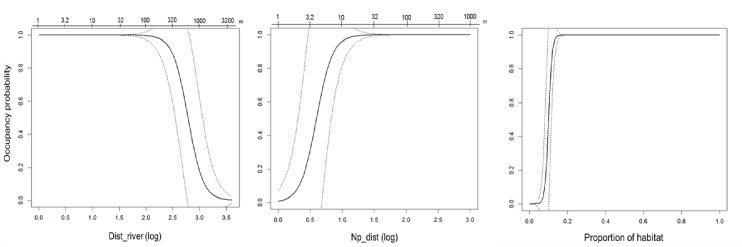
Predicted occupancy probability as function of distance to river (Dist_river), distance to nearest patch (Np_dist), and proportion of habitat in the best model at scale 750m.For Dist_river and Np_dist the x axis at the top represents distance values in meters.